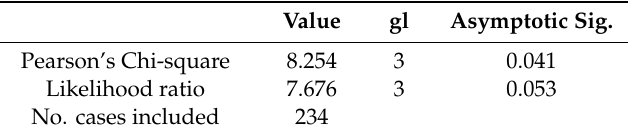
Pearson’s chi-square test for psychological distress according to conventional and hypoallergenic implant